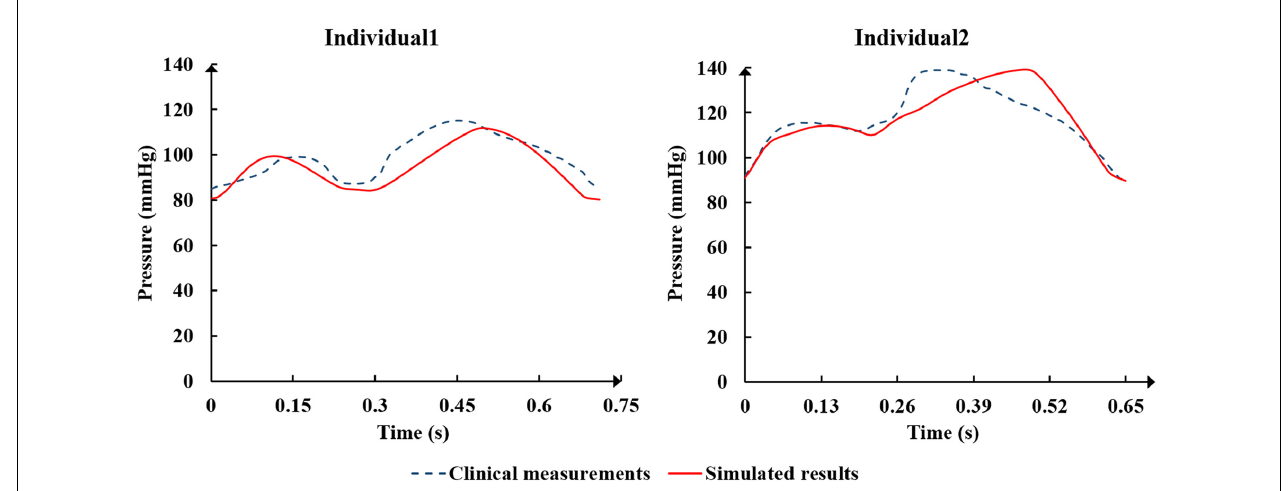
FIGURE 10 | The comparison of aortic pressure waveforms between the clinical measurements and the simulated results from the two individualized model in the resting state and counterpulsation state.